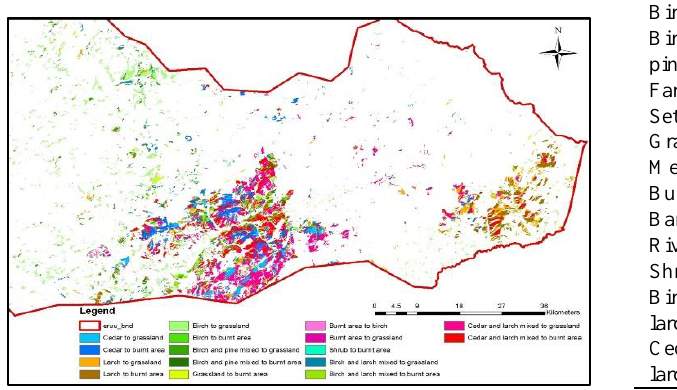
Figure 6. Forest type changes 2000 and 2011